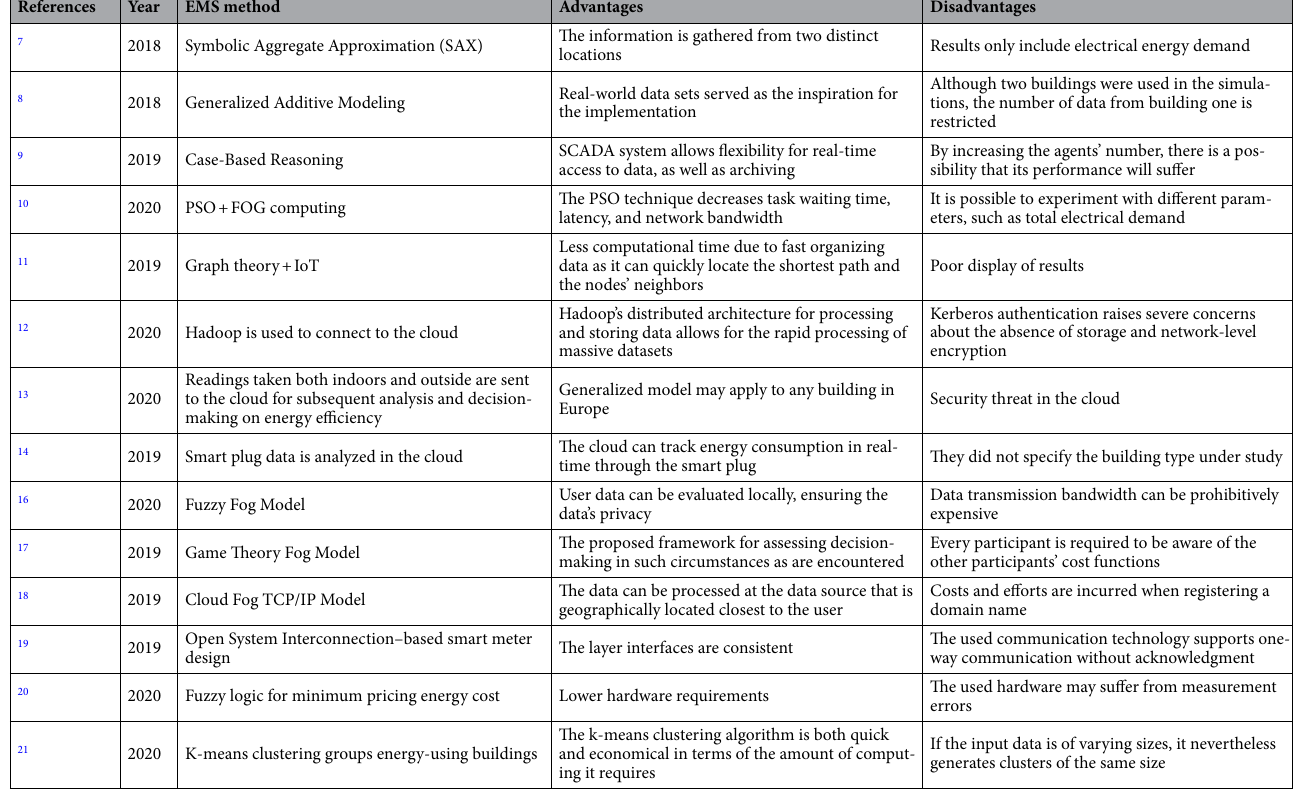
Table 1. A Summary of energy management techniques in smart buildings-based